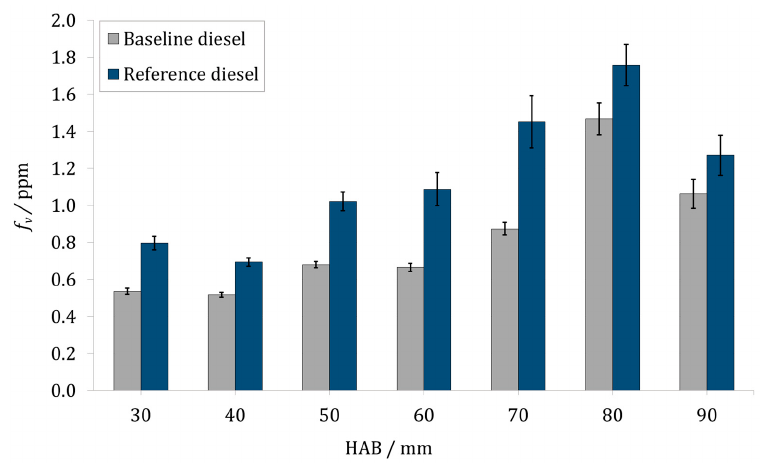
Figure 10. Comparison of the maximum f v measured for the reference diesel and baseline diesel between 30 and 90 mm above the burner (HAB), with corresponding standard deviations.